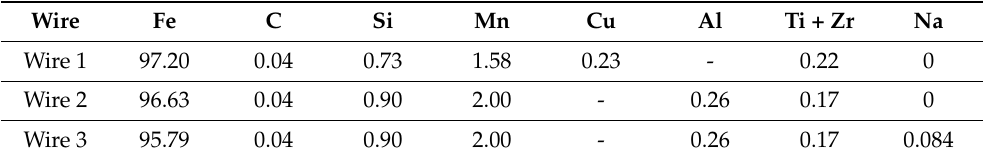
Table 3. Chemical compositions (mass%) of